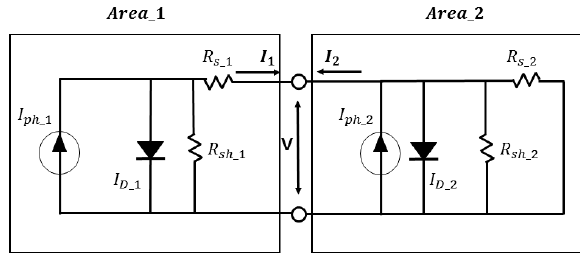
Figure 10. Equivalent circuit of a c-Si solar cell with 50% shading.